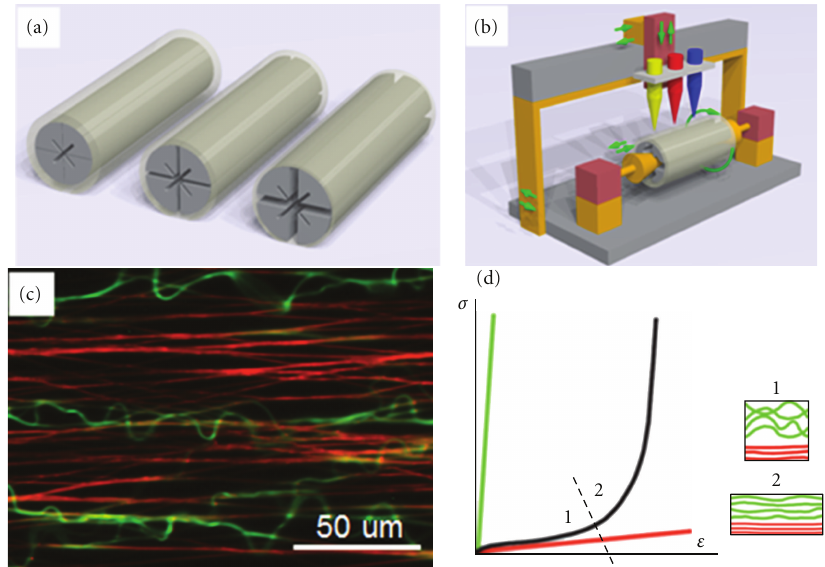
Figure 2: Robotic fabricator of compliant composite electrospun vascular graft. (a) Computer-aided design of rotational collecting cylinder with periodically changing external diameter; (b) Computer-aided design of robotic fabricator of compliant composite electrospun vascular graft (c) Confocal microscopy of compliant vascular graft fabricated from wavy (green) and nonwavy nanofibers (red); (d) Scheme explaining biomimetic mechanical behavior of compliant composite electrospun vascular graft.